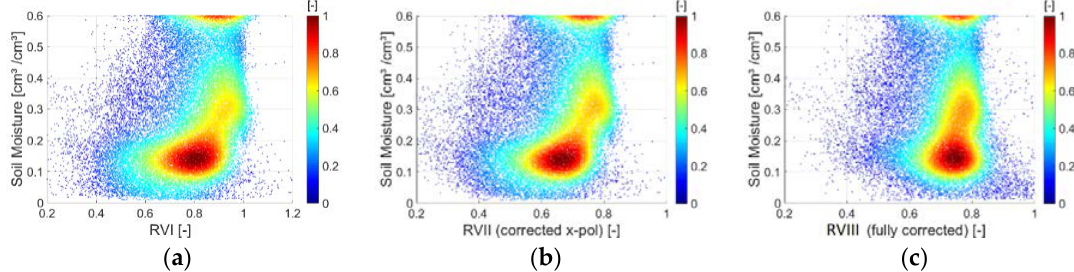
Figure 10. Correlation for the combined study areas between: ( a ) RVI [-]; ( b ) x-pol corrected RVII [-]; ( c ) fully corrected RVIII [-] and volumetric surface soil moisture [cm 3 /cm 3 ] derived from SMAP [18,35].